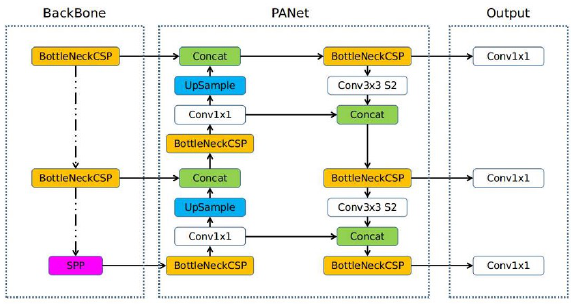
Figure 2: The network architecture of YOLOv5 (adapted from (Jocher et al., 2020)).